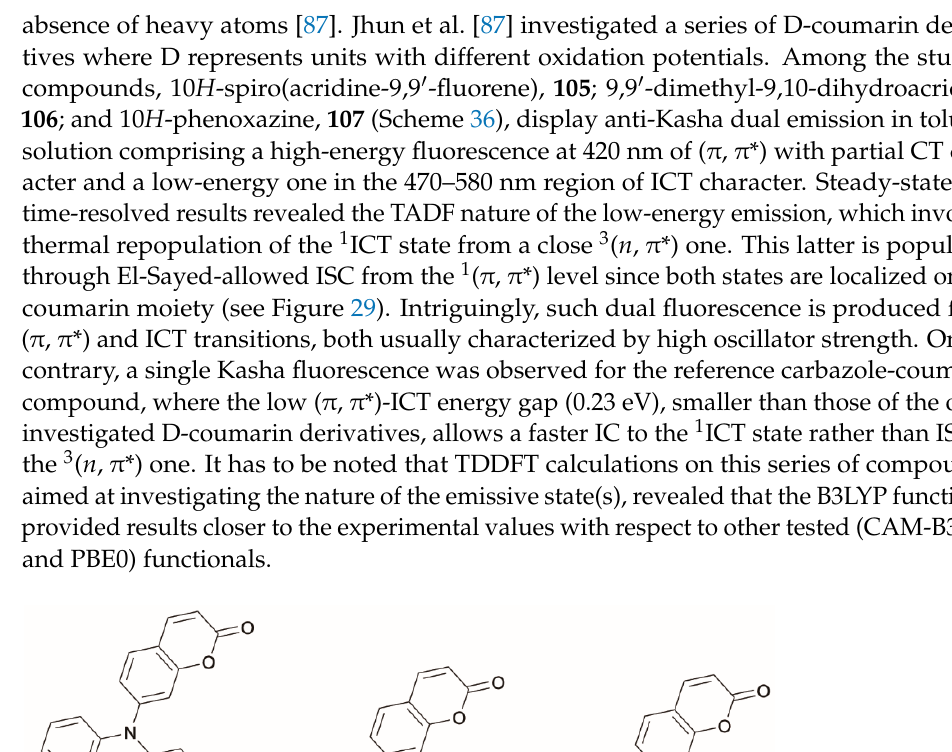
39 of 45 Figure 28. Possible mechanism for the dynamic stimuli-responsive fluorescence switch. S 0E : ground state of enol form of 104 ; S nE : excited state of enol form of 104 ; S 0K : ground state of keto form of 104 ; S nK : excited state of keto form of 104 ; S 0SE : ground state of enol form of solvated 104 ; S nSE : excited